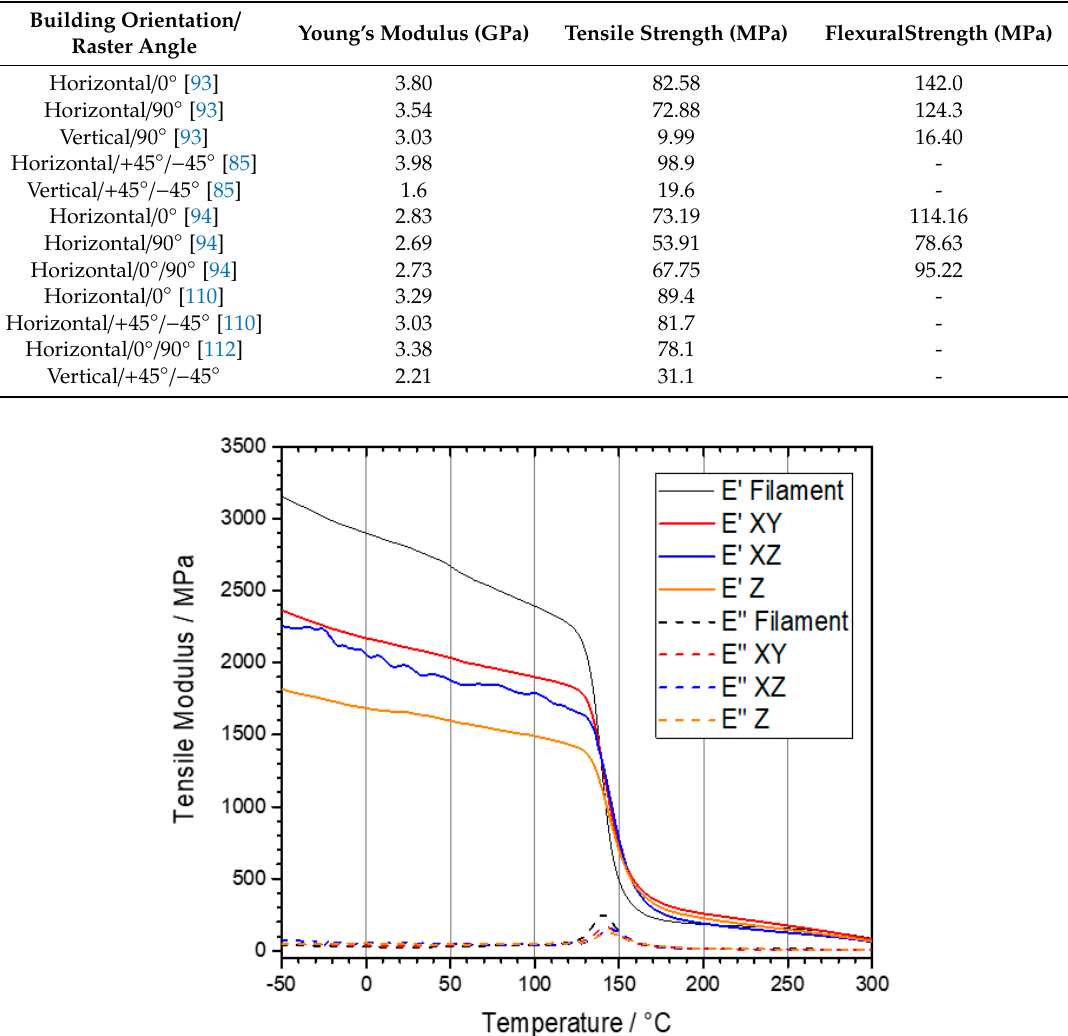
Table 4. E ff ect of raster layer orientation on the mechanical properties of PEEK.